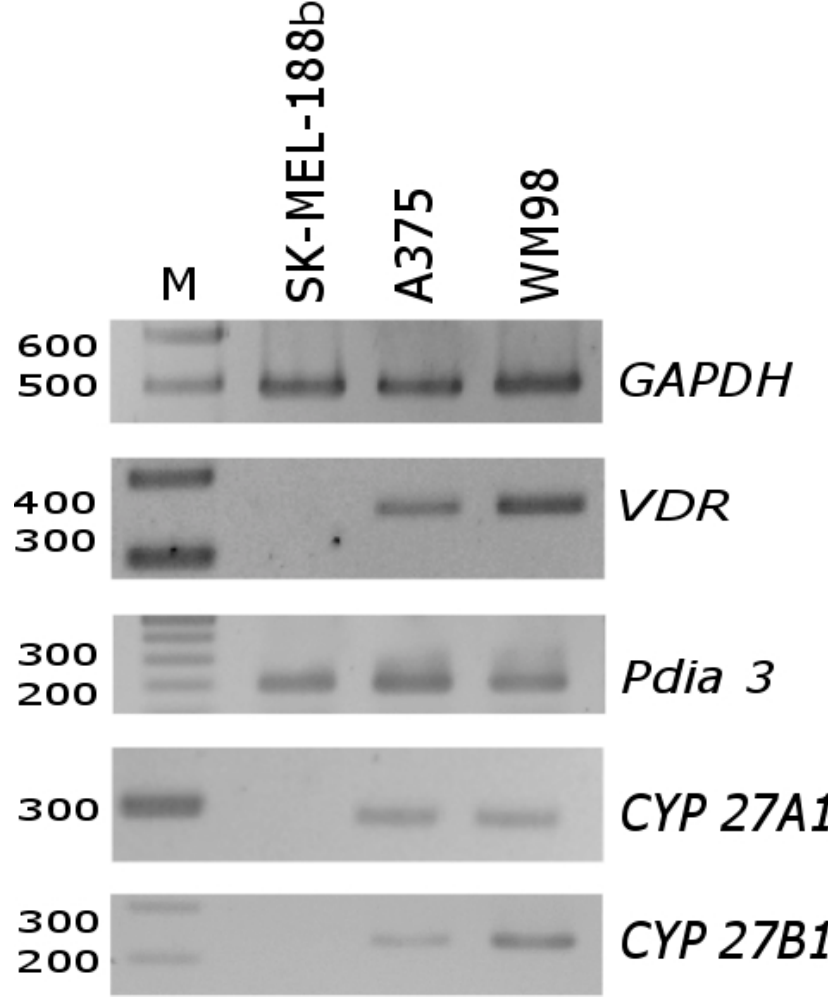
Figure 3. Differences in mRNA level of VDR , PDIA3 , CYP27A1 and CYP27B1 genes in SK-MEL-188b cells in comparison with A375 and WM98 cells. Glyceraldehyde 3-phosphate dehydrogenase (GAPDH) was used as a reporter gene to normalize all samples. See Table S1 for primer sequences and the predicted length of PCR